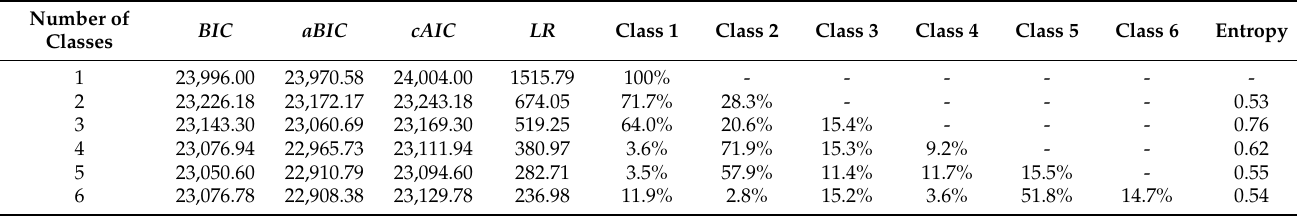
Table 3. Latent class analysis results for the identification of the number of profiles among adolescents aged 11–18 in Mauritius, 2017. Number of